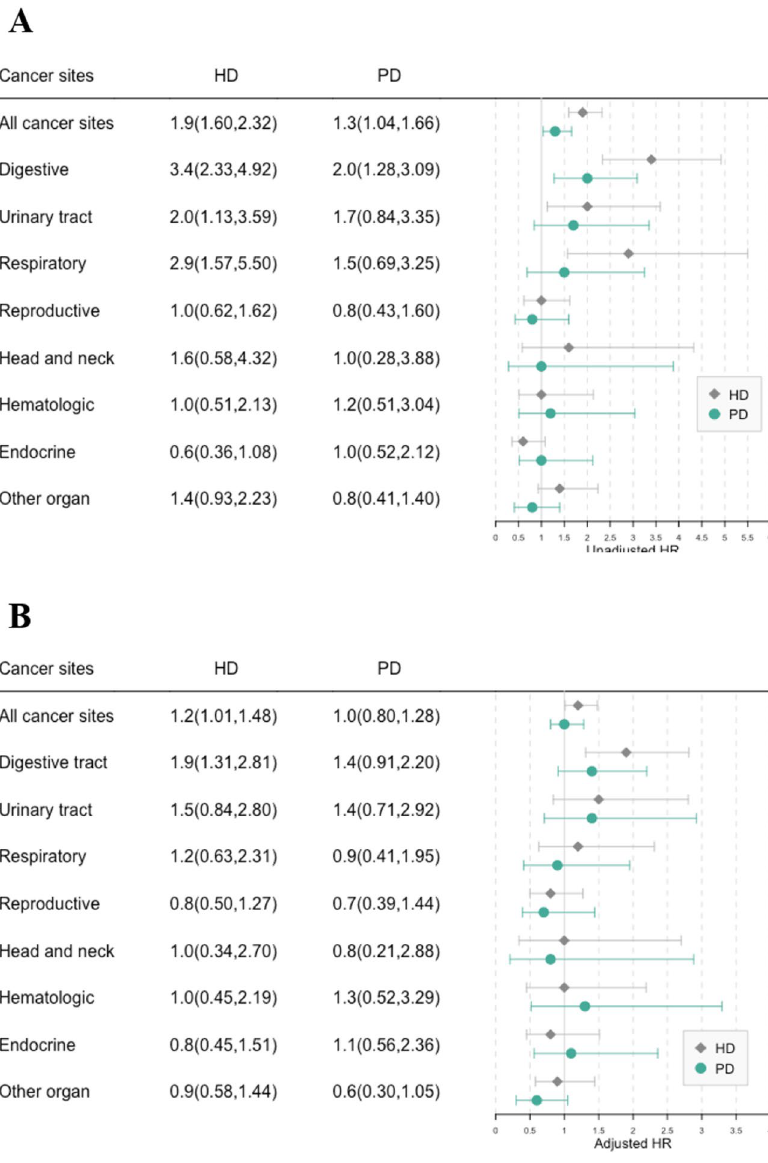
Figure 3. Forest plot of the cancer risk among patients undergoing hemodialysis and peritoneal dialysis versus kidney transplant. HD, hemodialysis; PD, peritoneal dialysis; HR, hazard ratio (with 95% confidence interval). ( A ) Univariate Cox regression model; ( B ) Multivariable Cox model adjusting for the effects of age group, sex, diabetes, hypertension, cardiovascular, cerebrovascular, chronic lung disease, and chronic liver